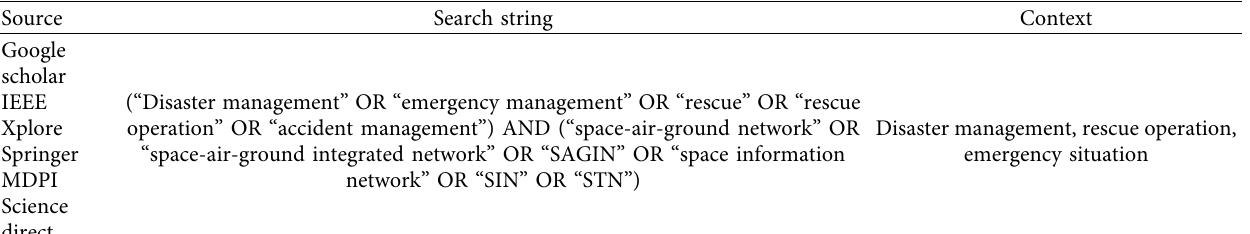
Table 3: Search string for the collection of papers from digital